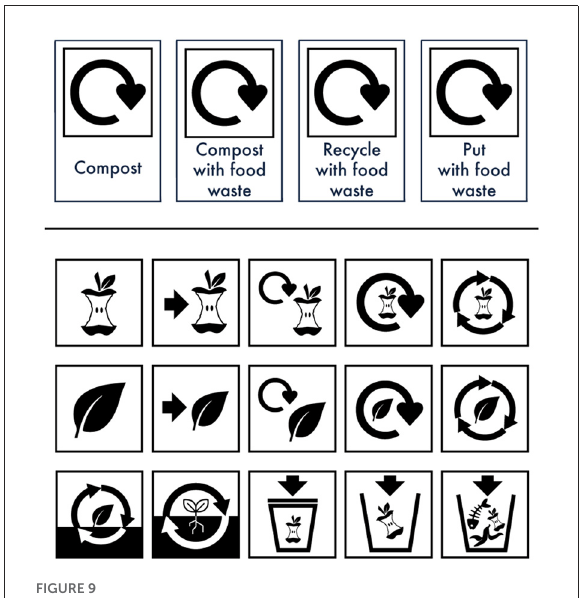
FIGURE9 Examples of the disposal instruction labels